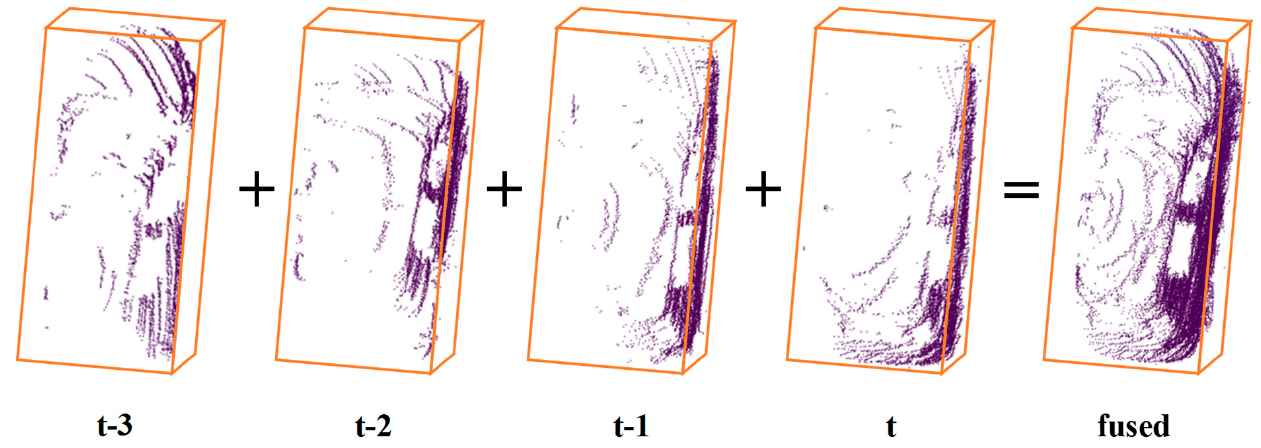
Figure 3. Schematic diagram of instance-level point cloud fusion based on multiple scans of data.